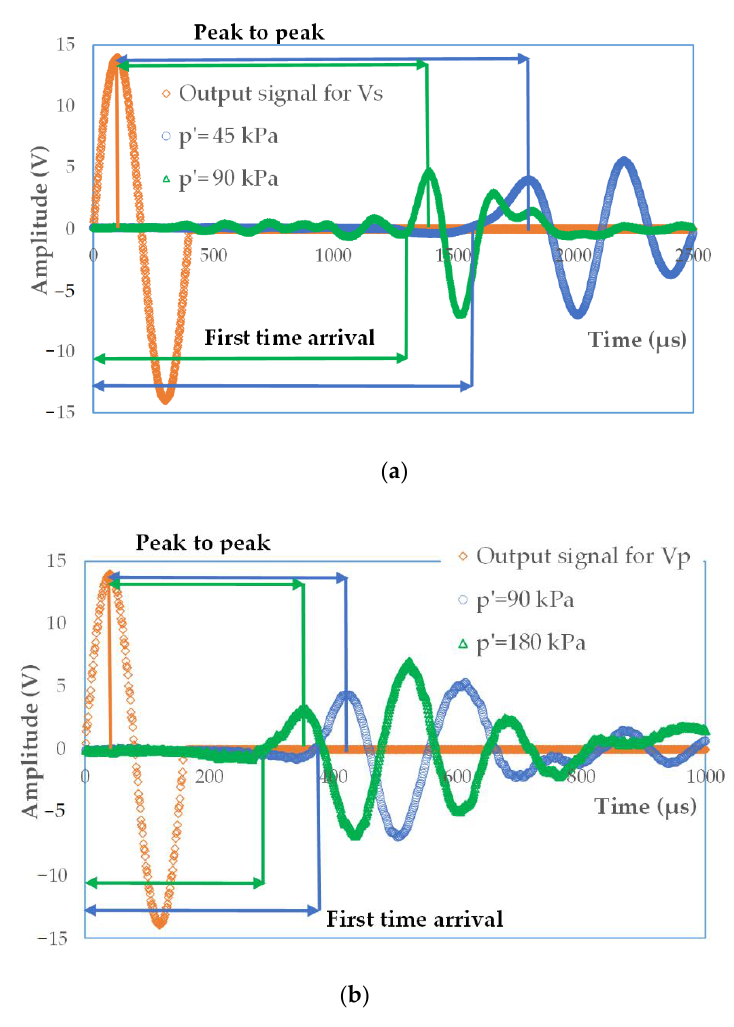
Figure 4. Example of the signal analysis/interpretation for ( a ) the bender element tests for specimen S11, p (cid:48) = 45 kPa, f = 10 kHz, and ( b ) the extender element tests for specimen S12, p (cid:48) = 90 kPa, f = 12.5